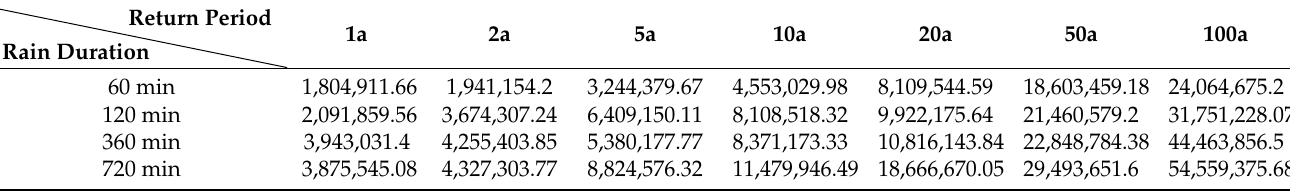
Table 4. Peak volumes of all the rainstorm scenarios. Peak volumes (m 3 ).